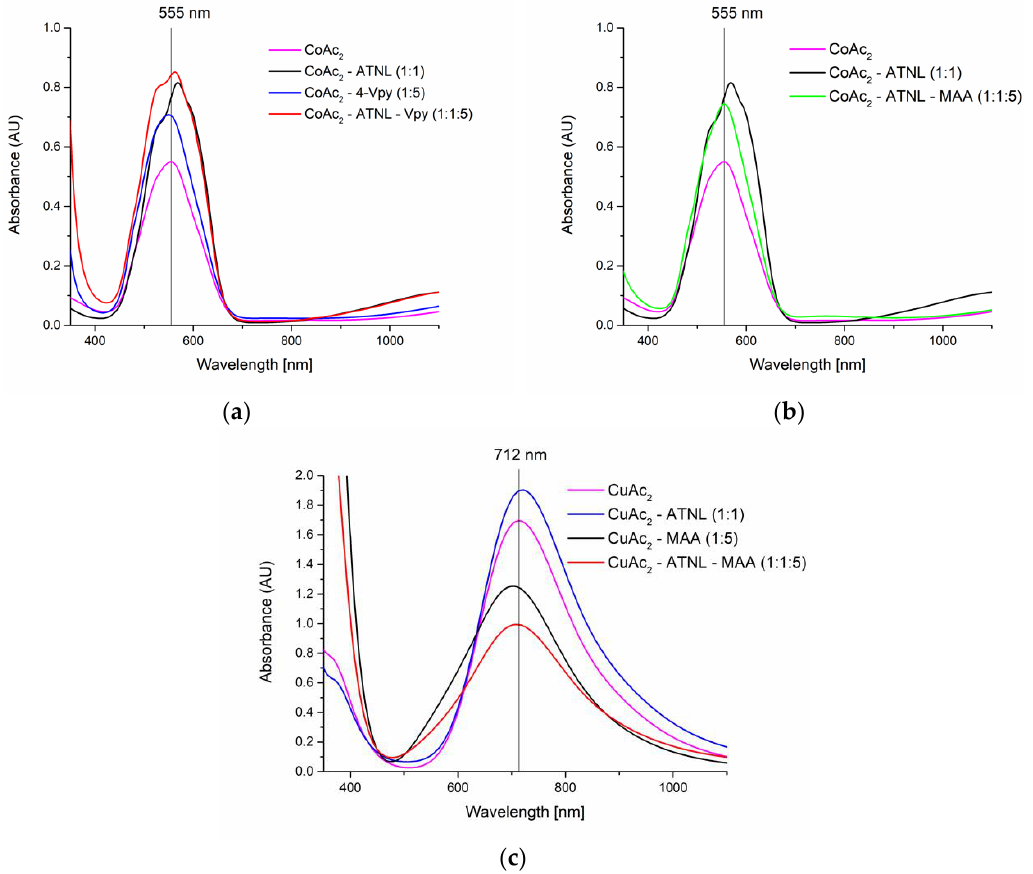
Figure 1. Electronic spectra of Co(II) complexes in DMF/DMSO 1:5 ( v / v ) with ( a ) binary and ternary Co(II) complexes with ATNL (1:1 molar ratio) and 4-VPy (1:5 molar ratio); ( b ) binary and ternary Co(II) complexes with ATNL (1:1 molar ratio) and MAA (1:5 molar ratio); ( c ) binary and ternary Cu(II) complexes with ATNL (1:1 molar ratio) and MAA (1:5 molar ratio).